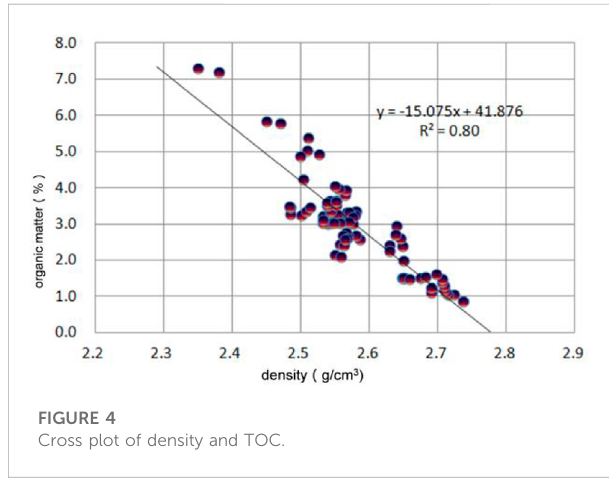
FIGURE 4 Cross plot of density and TOC.